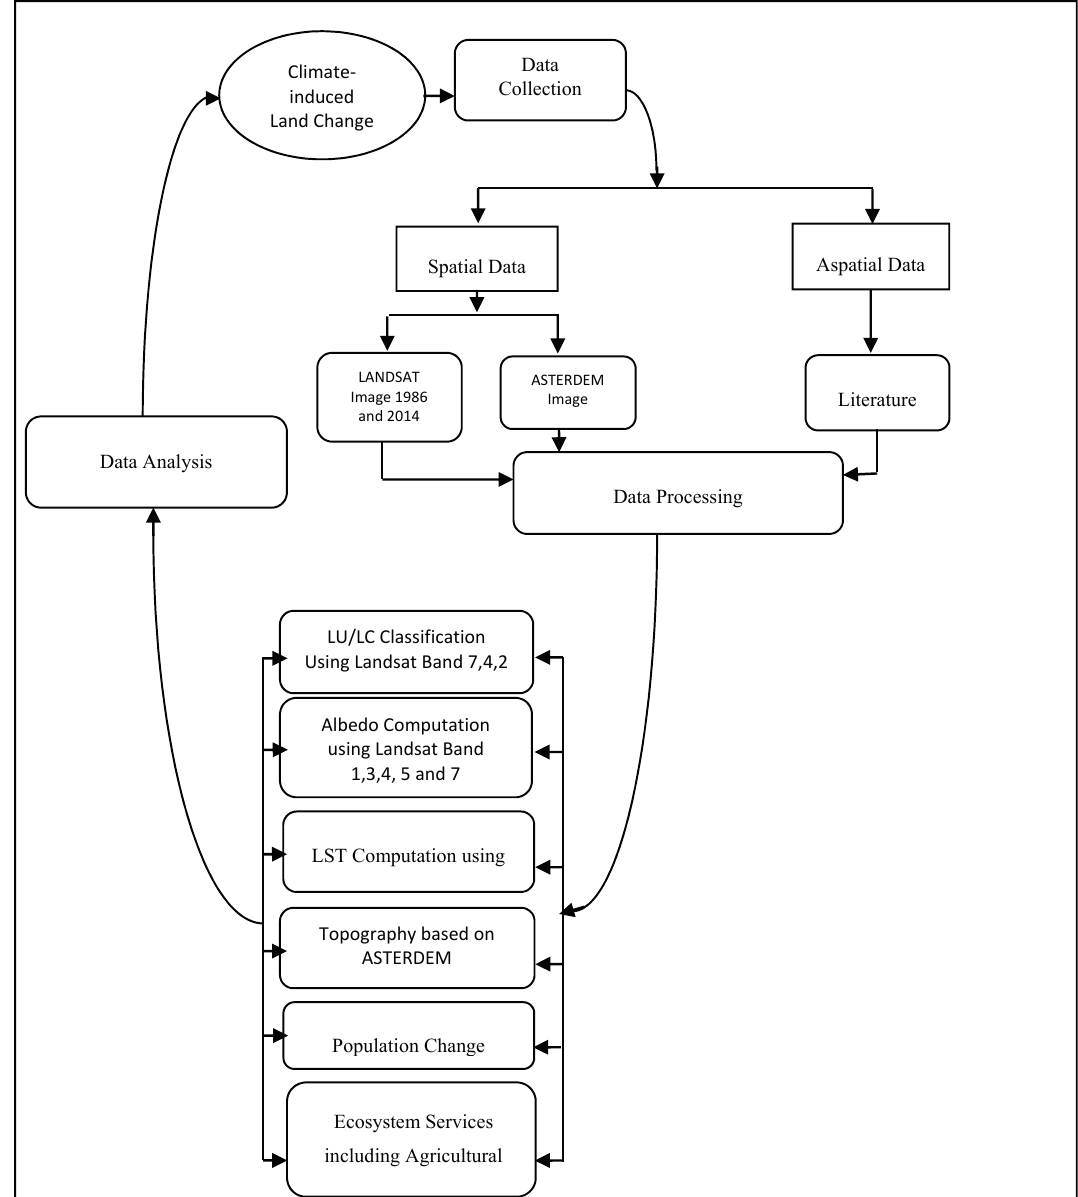
Figure 3. The methodological framework for the